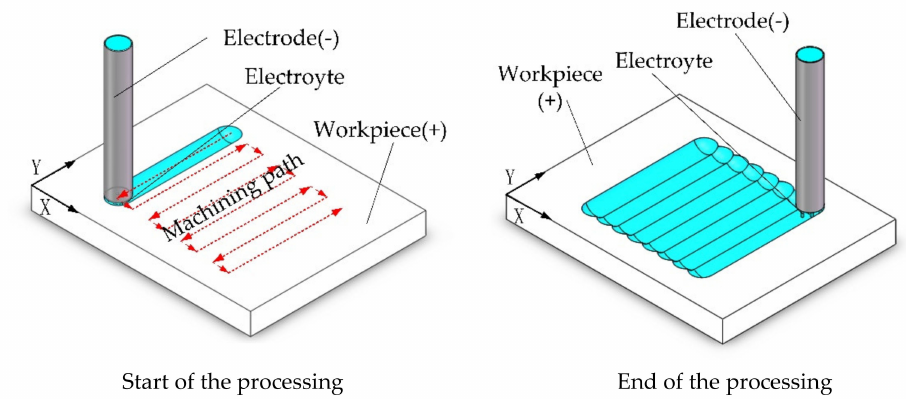
Figure 13. Diagram showing firstly processing